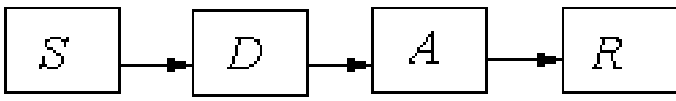
Figure 5. Structure of the general-purpose image recognition system.